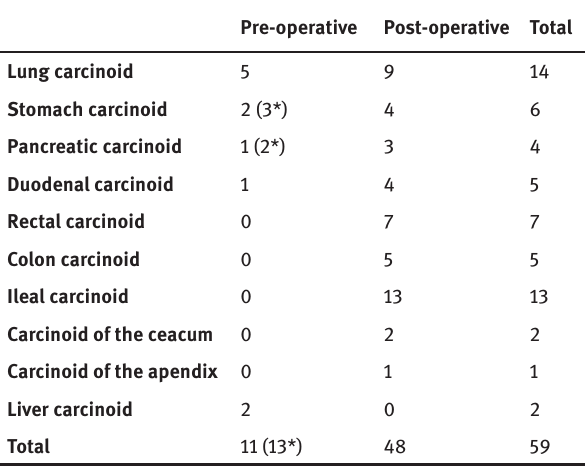
Table 1: Clinical status and localization of carcinoid tumors.